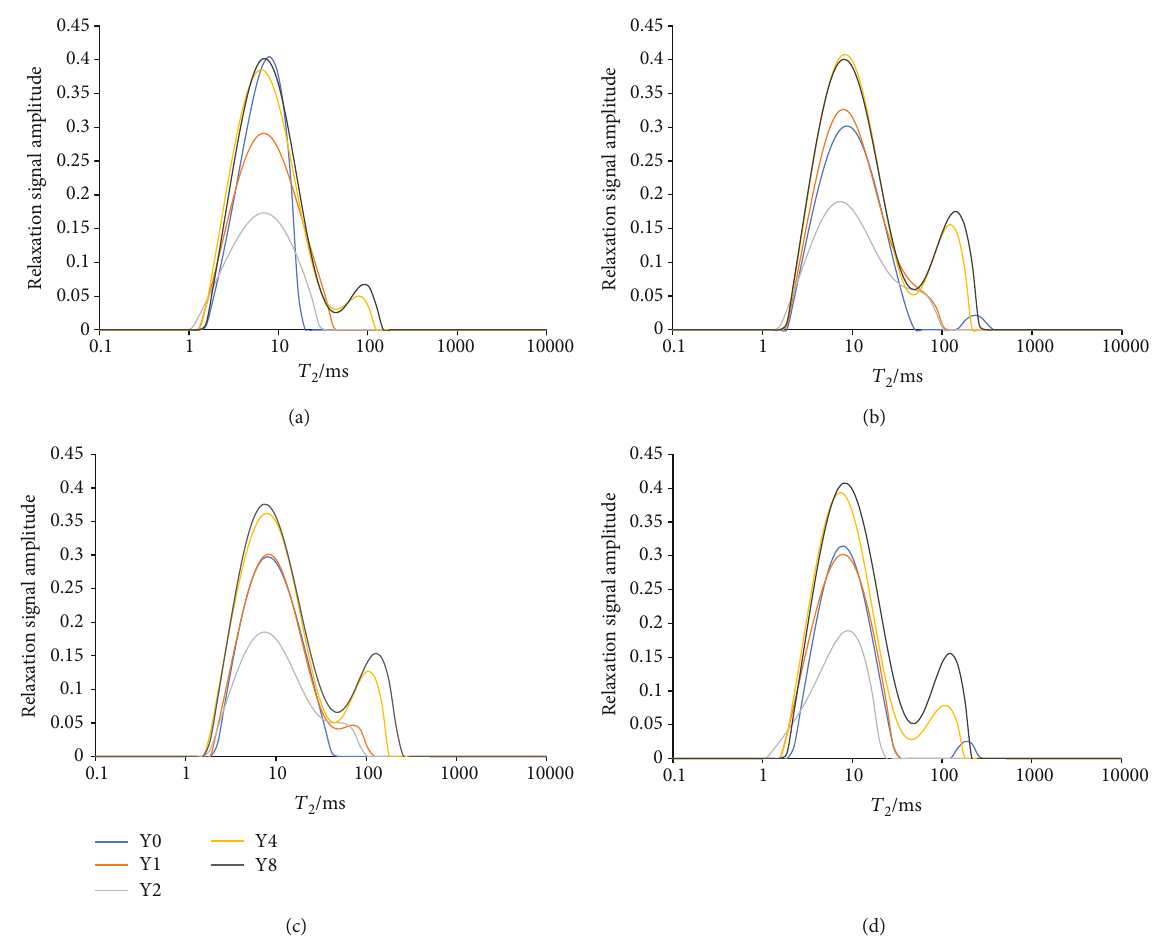
Figure 12: NMR T2 spectrum of four samples saturated with slick water for 1, 2, 4, and 8